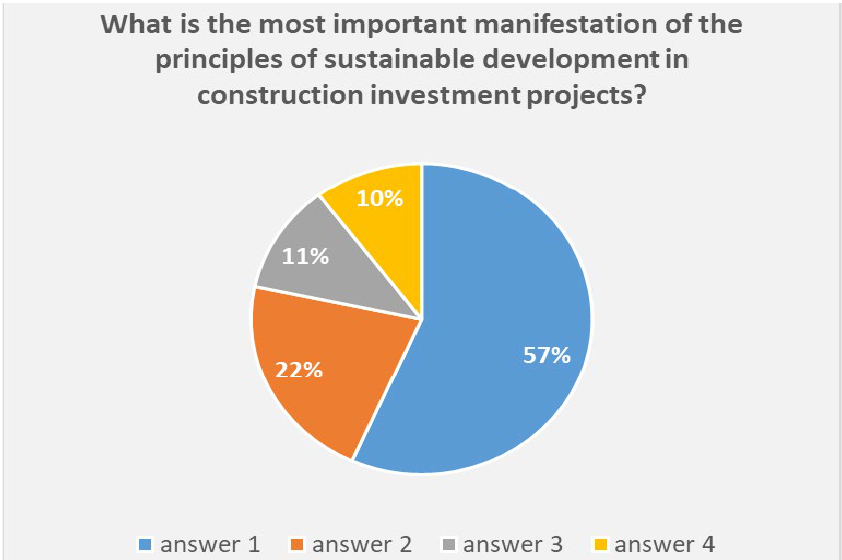
Figure 5. Hierarchy of principles of sustainable development in construction projects according to respondents (answer 1 (blue) = R1, answer 2 (orange) = R2, answer 3 (grey) = R4, answer 4 (yellow) = R3).